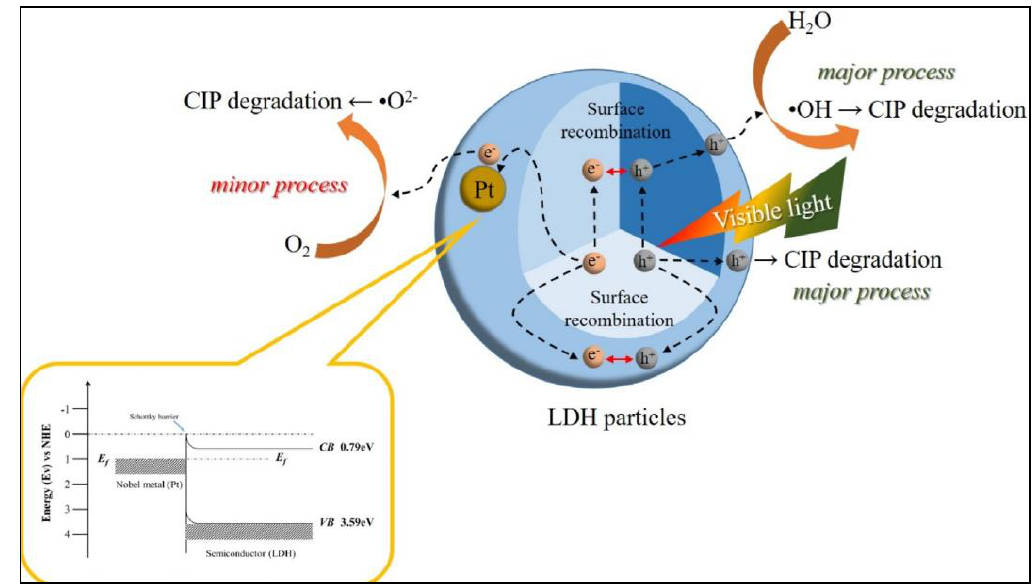
Figure 7. The proposed mechanism for the degradation of CIP using layered double hydroxides (LDHs) Pt hybrid. ESR spin trap experiment was used to determine the dominant free radicals. Scavengers like ascorbic acid, EDTA-2Na and tert-butyl alcohol were used to trap superoxide anion radicals, photogenerated holes, and hydroxyl radicals. Here, metallic Pt acts as springboard that facilitates charge separation and electron movement through Pt/LDH heterojunction interfaces. When Pt is attached to the LDH surface, surface recombination is reduced as the photogenerated electrons transfer to Pt and cannot return due to the presence of Schottky barrier. Simultaneously, the photogenerated holes migrates to LDH external surface and degrades CIP by reacting with H 2 O to form. OH. Adapted with permission from [99]. Copyright 2020 Elsevier.